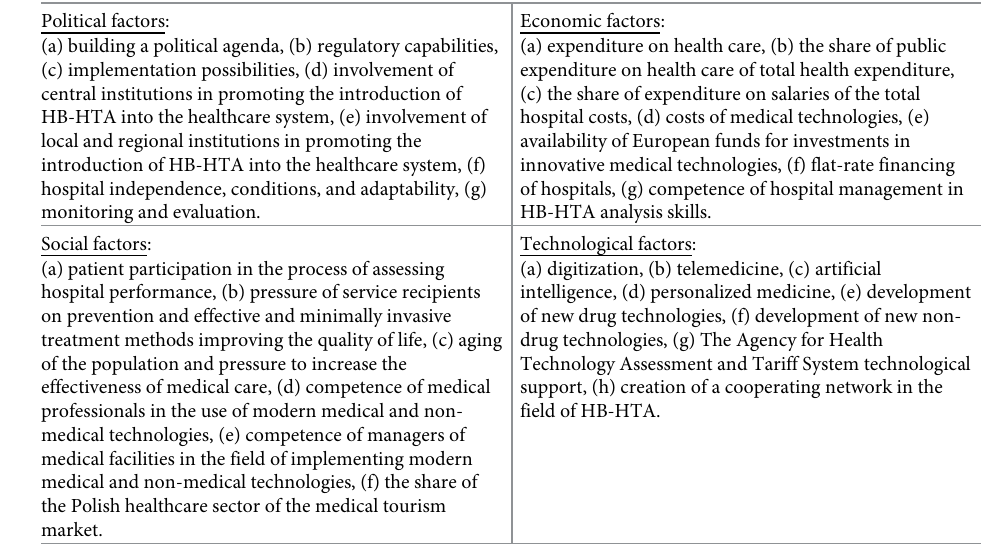
Table 2. Results of the PEST